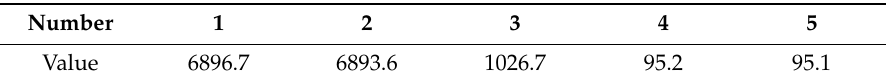
Table 2. Partial singular values of approximation coe ffi cient ca 4 .